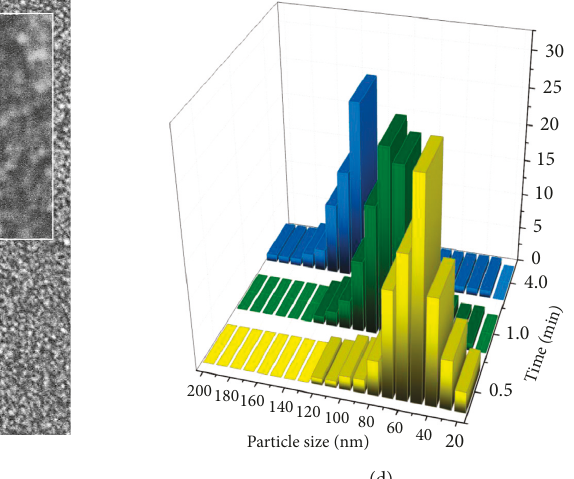
° C 4 ] by the GR method in DMSO at 50